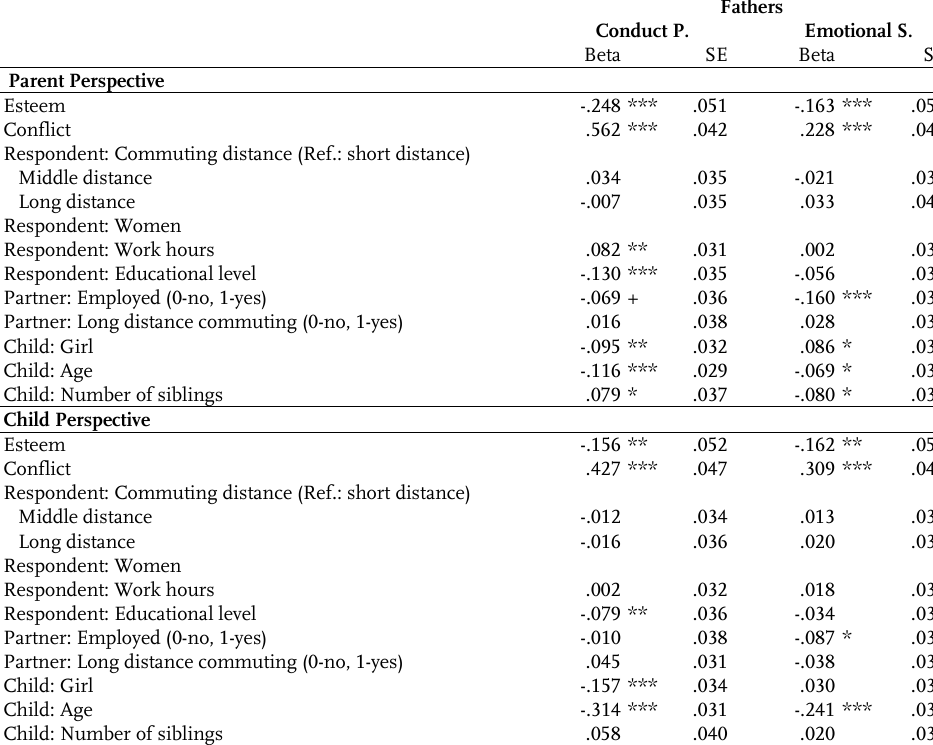
Table 5 : The association between the parent-child relationship (measured by esteem and conflict) and the child’s well-being (measured by conduct problems and emotional symptoms)